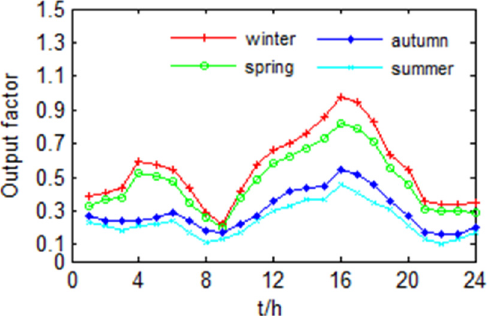
Figure 2. Timing characteristics of wind power output in different seasons.